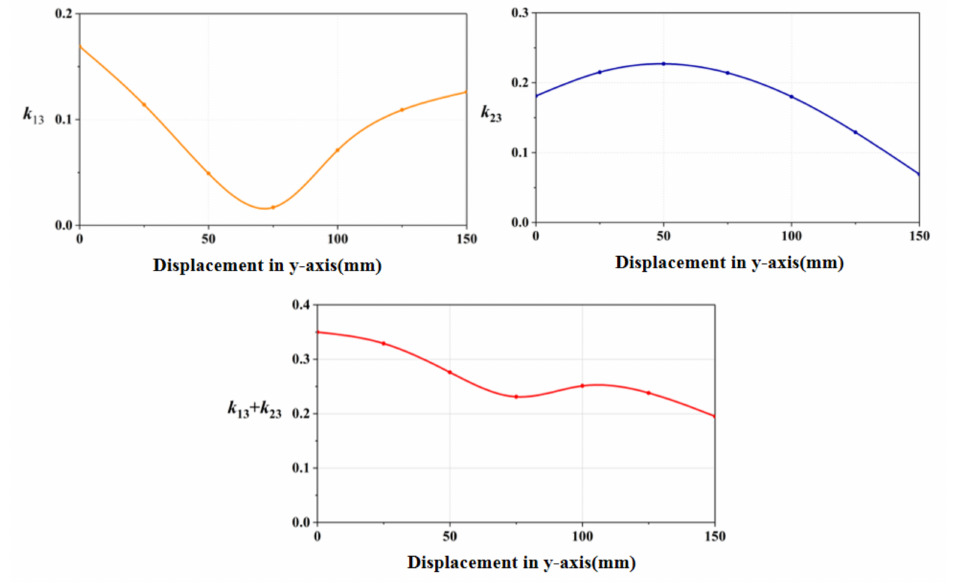
Figure 10. Variation of the coupling coefficient with